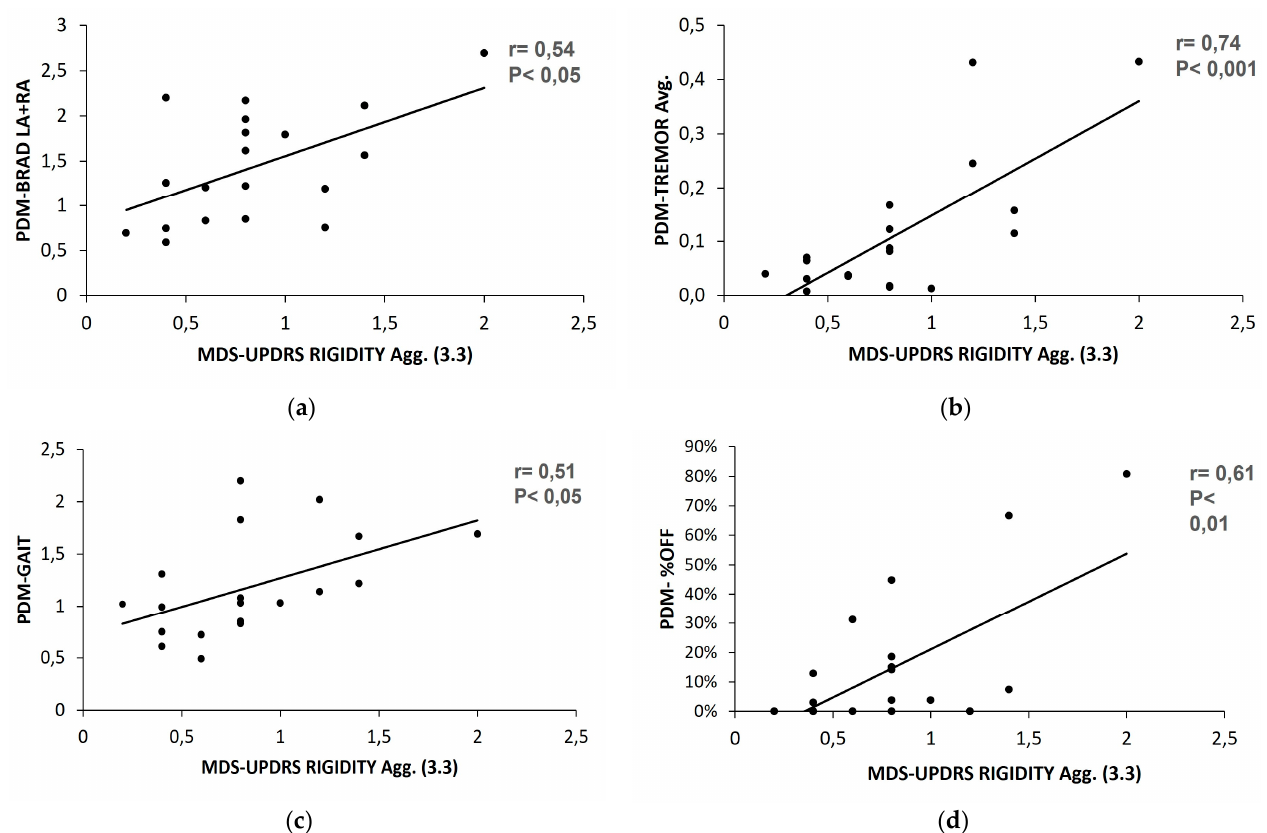
Figure 4. The correlation between the PDMonitor ® average values and MDS-UPDRS item 3.3 average score on ( a ) bradykinesia; ( b ) tremor; ( c ) gait; ( d ) %OFF.